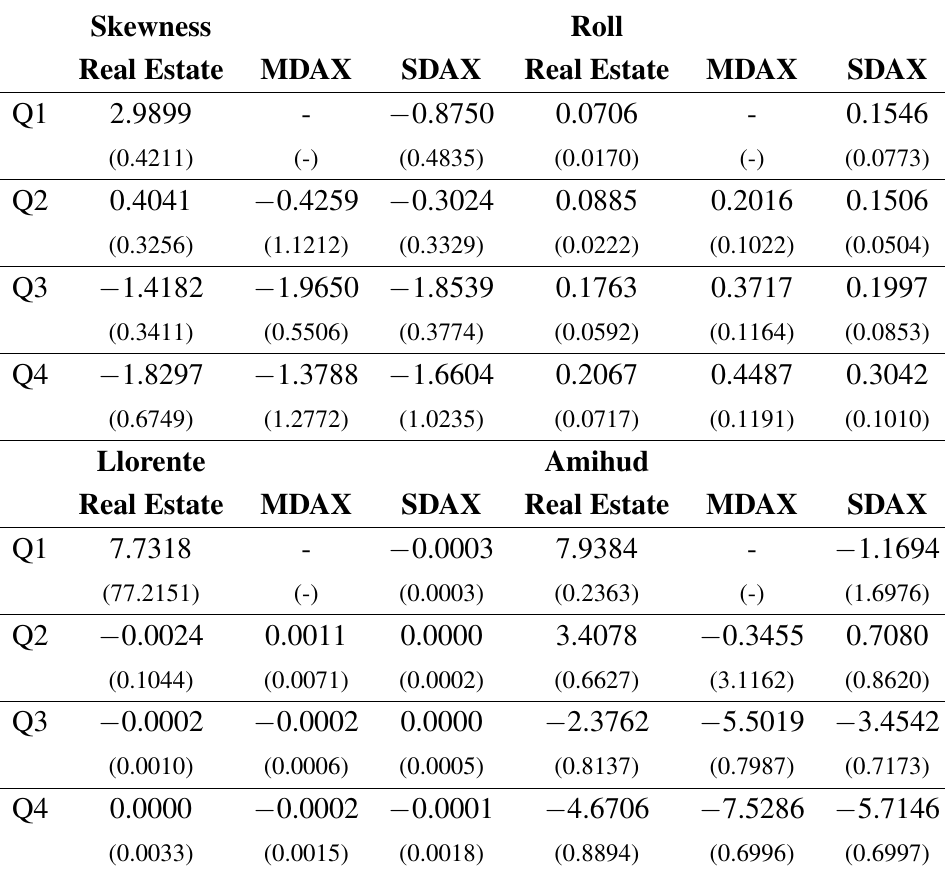
Table 7. Quartile descriptive statistics of real estate, MDAX and SDAX.